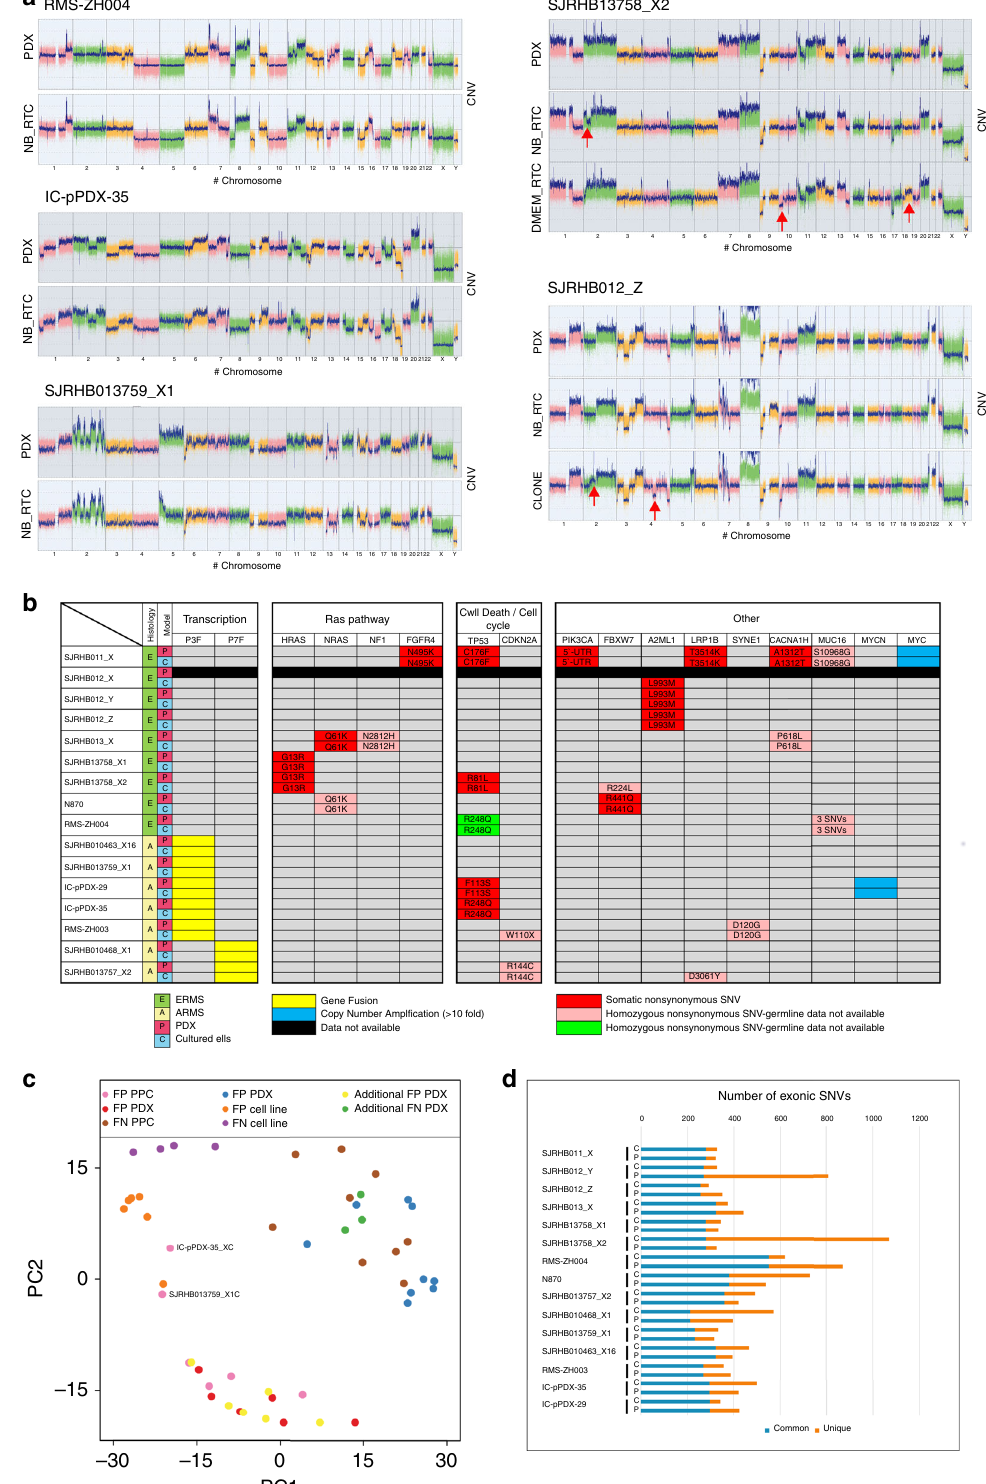
validated in all FP-RMS cultures by Western blot (Supplementary Fig. 6B). We then used the genewise target coverage of the exome seq data to identify focally ampli fi ed genes and matched the fi ndings with the aCGH data. We detected ampli fi cations of MYC (one FN-RMS) and MYCN (one FP-RMS) (Fig. 3b and Supplementary Table. 1).